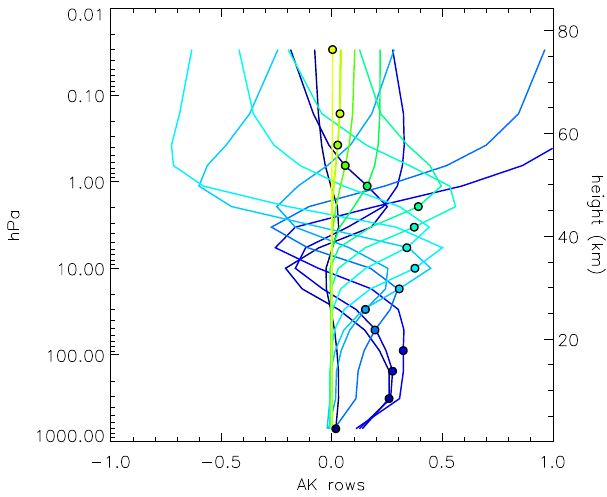
Fig. 11b. Averaging kernels for the 16-layer GOME-2 retrieval over Europe that was also used in Fig. 1. The circles give the nominal altitude for the retrieval. The averaging kernels corresponding to the albedo and the additive offset have not been